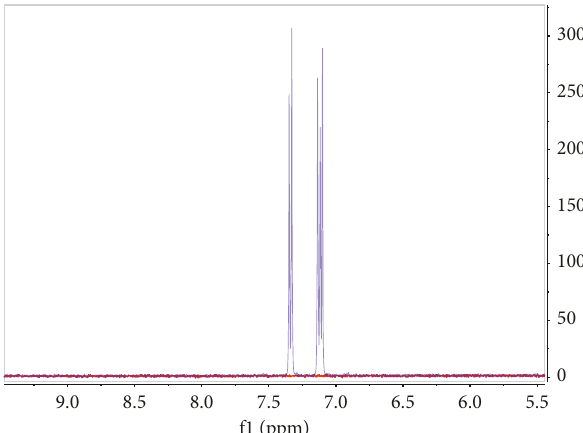
Figure 2: NMR spectra of a mineral oil sample containing 5% of 3- (4-methylbenzylidene)camphor. The blue 1 H NMR spectra show the signals of a direct measurement in cyclohexane/acetone-d 6 , while the red spectra represent the result of the same sample following SPE cleanup. The aromatic light filter is not detectable following SPE.